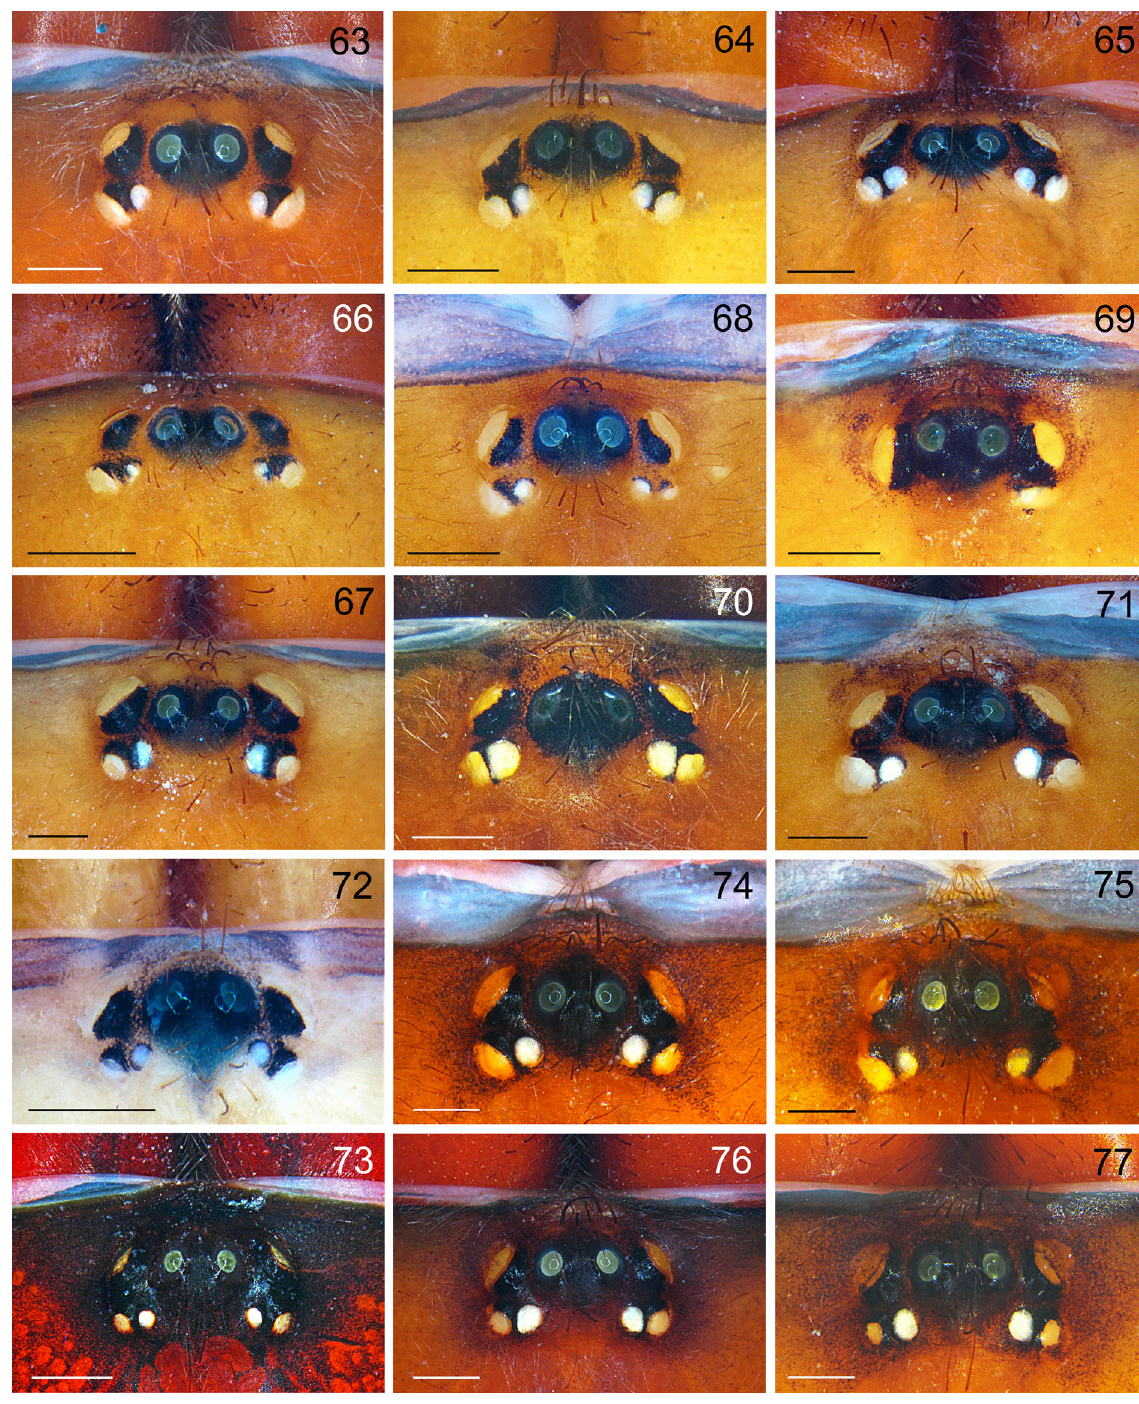
Figs 63–77. Anemesia spp., ♀♀, clypeus and eye tubercle, dorsal views. 63 . A. birulai (Spassky, 1937) (Kepele). 64 . A. pococki sp. nov. (paratype). 65 . A. tubifex (Pocock, 1889) (Kalaimor). 66 . A.